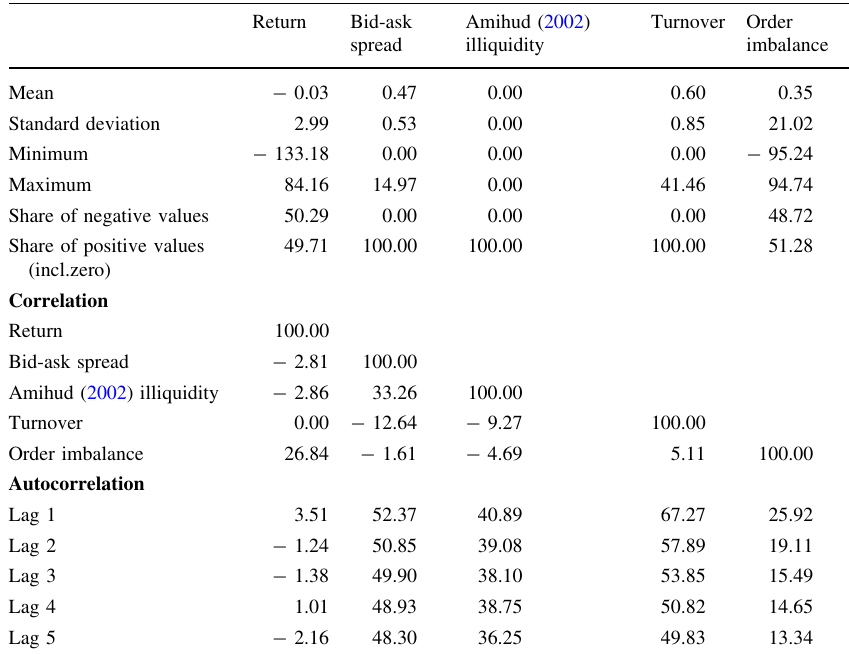
Return Bid-ask Amihud (2002) Turnover Order spread illiquidity imbalance